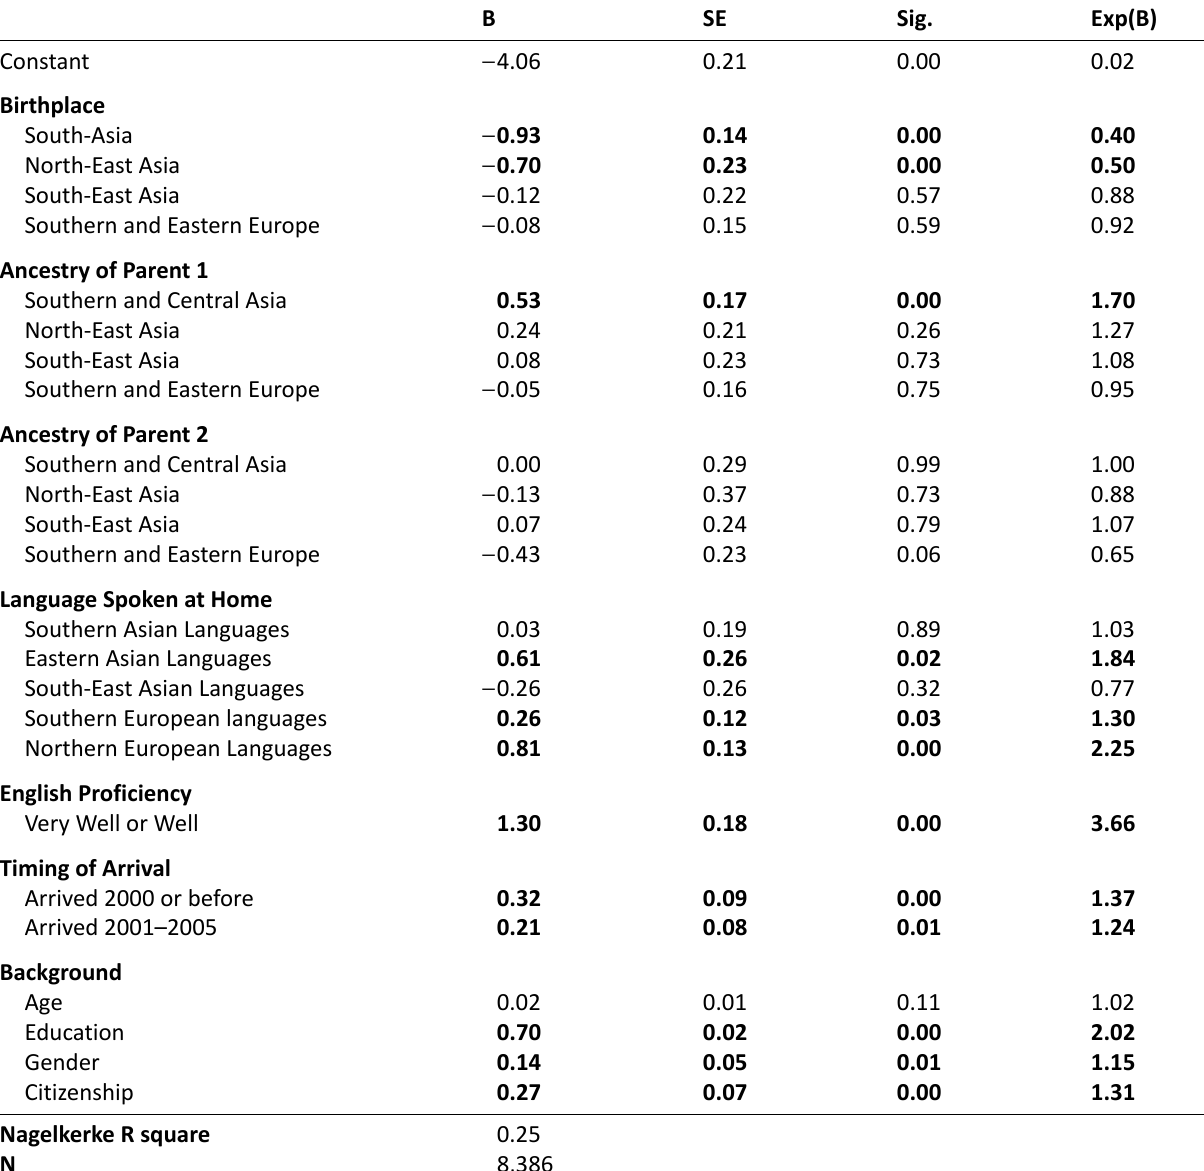
Table 6. Logistic Regression Model estimating effects of origins and background on occupation, census, 2011. B SE